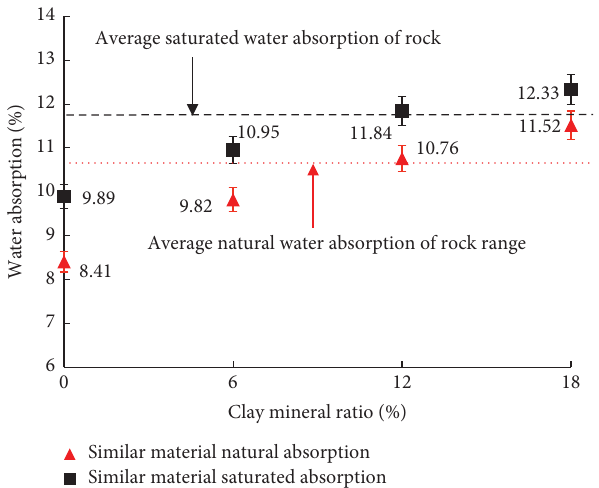
Figure 11: Water absorption and saturated water absorption.